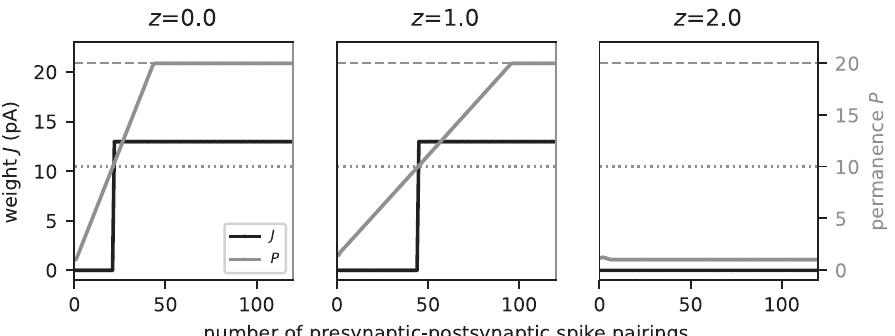
Fig 4. Homeostatic regulation of the spike-timing-dependent structural plasticity by the dAP activity. Evolution of the synaptic permanence (gray) and weight (black) during repetitive presynaptic-postsynaptic spike pairing for different levels of the dAP activity. In the depicted example, presynaptic spikes precede the postsynaptic spikes by 40 ms for each spike pairing. Consecutive spike pairs are separated by a 200 ms interval. In each panel, the postsynaptic dAP trace is clamped at a different value: z = 0 (left), z = 1 (middle), z = 2 (right). The dAP target activity is fixed at z � = 1. The horizontal dashed and dotted lines mark the maximum permanence P max and the maturity threshold θ P ,